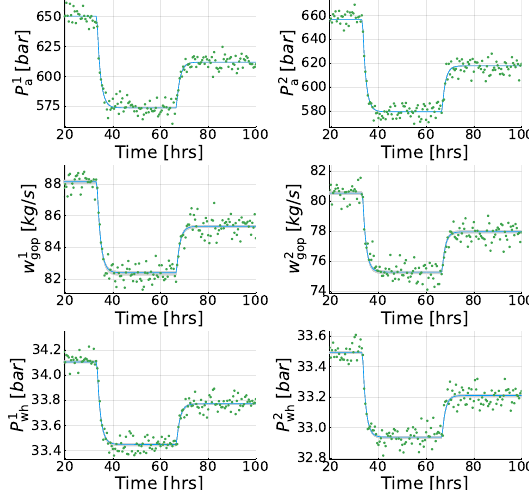
Figure 7: Data retrodiction of measured outputs (grey) compared to the original noisy data (green) and the nominal model solution that was used to generate the data (blue).